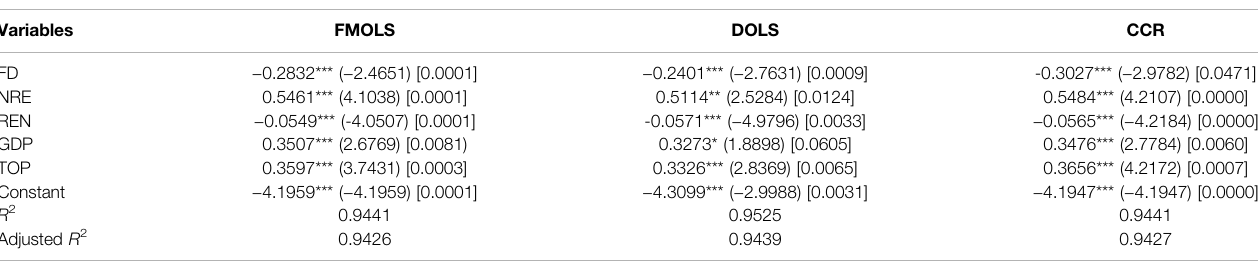
TABLE 5 | Long-run results.